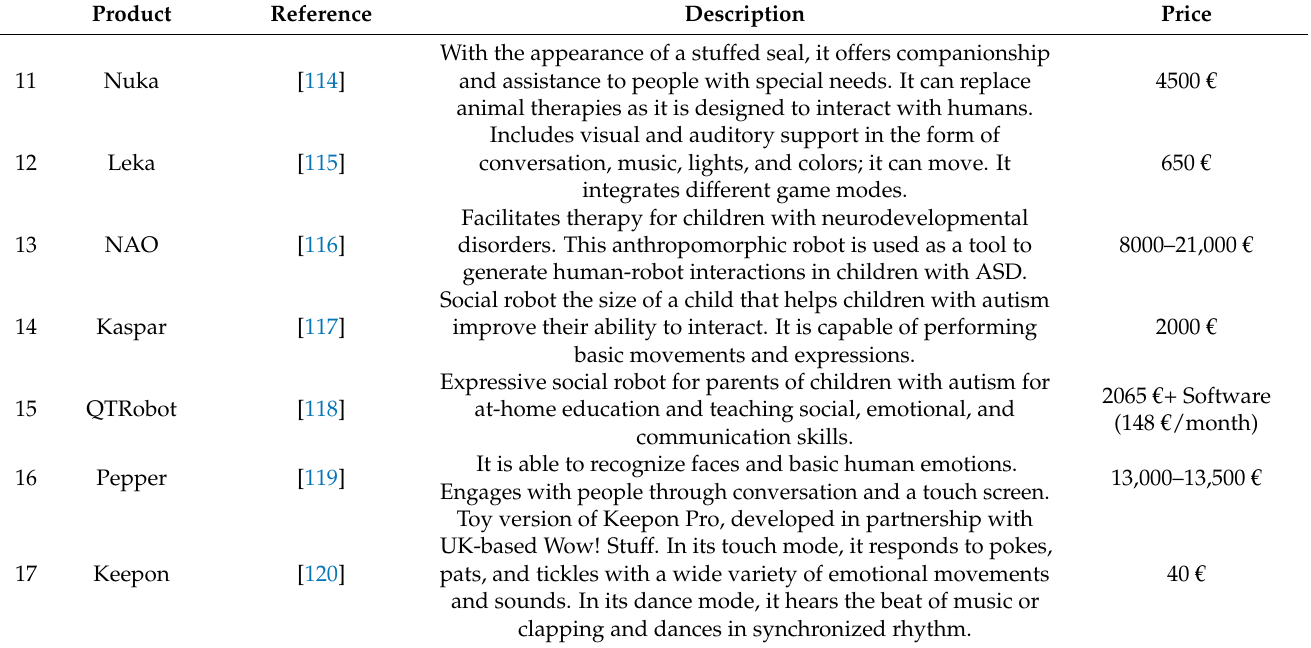
Table 16. Sample of commercial products in the form of robots.